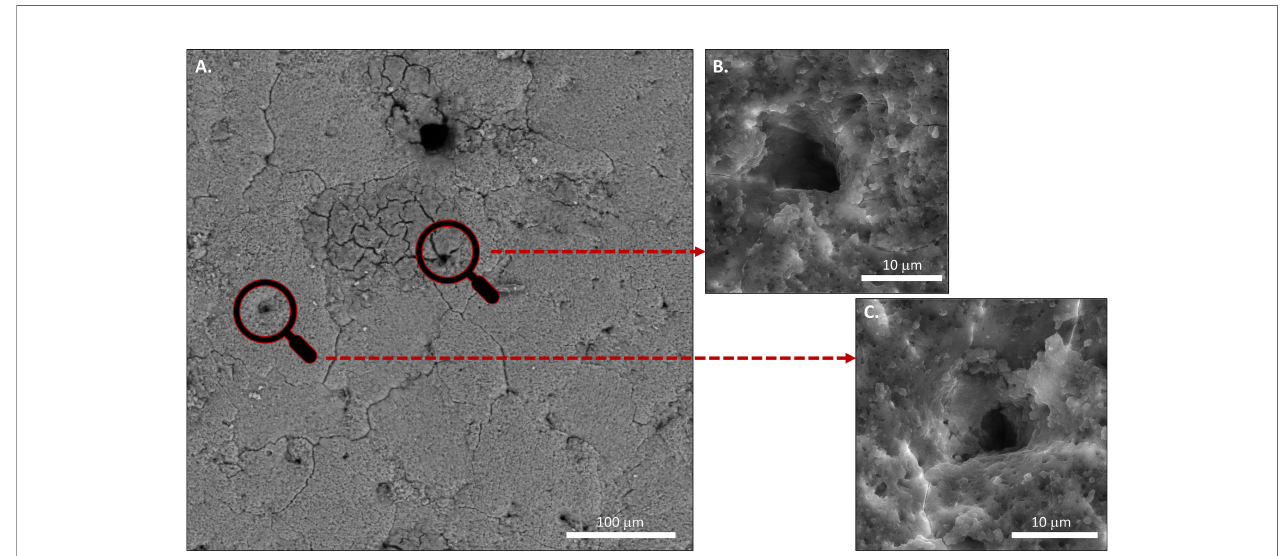
FIGURE 10 | Scanning electron microscopy (SEM) images of (A) Outer surface of chicken eggshell showing openings of pores at 1000x. (B) and (C) at higher magni fi cation 5000X. (Original fi gure by